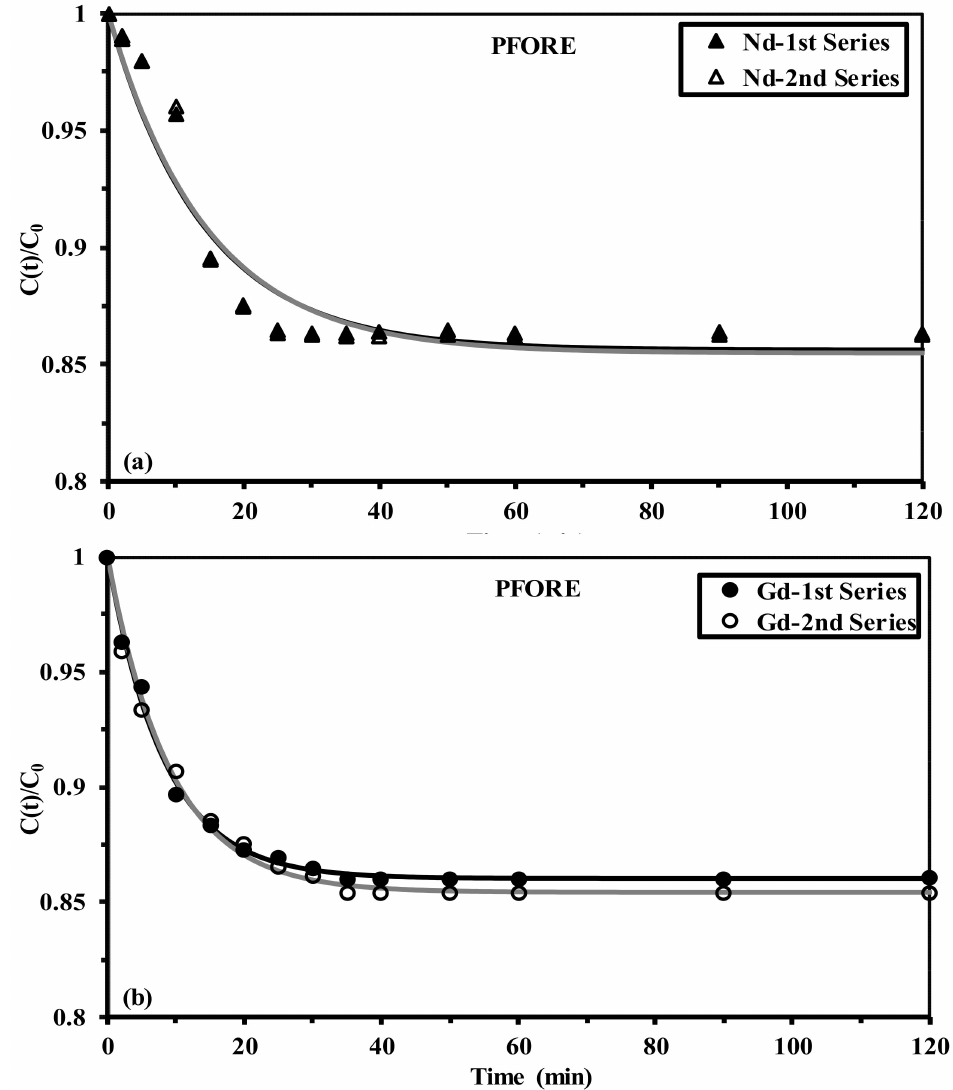
Figure 7. Nd(III) and Gd(III) uptake kinetics using mesoporous composite functionalized sorbent— modeling with the pseudo-first-order rate equation (C 0 : 0.65–0.71 mmol metal L − 1 ; pH 0 : 5; pHeq: 4.69–4.76; SD: 0.25 g L − 1 ; agitation speed: 170 rpm; T: 22 ± 2 ◦